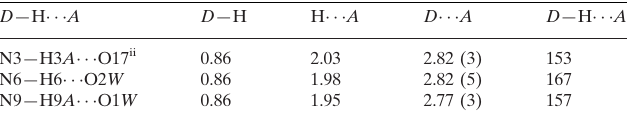
Hydrogen-bond geometry (A˚ , (cid:4) ). D —H (cid:2)(cid:2)(cid:2)